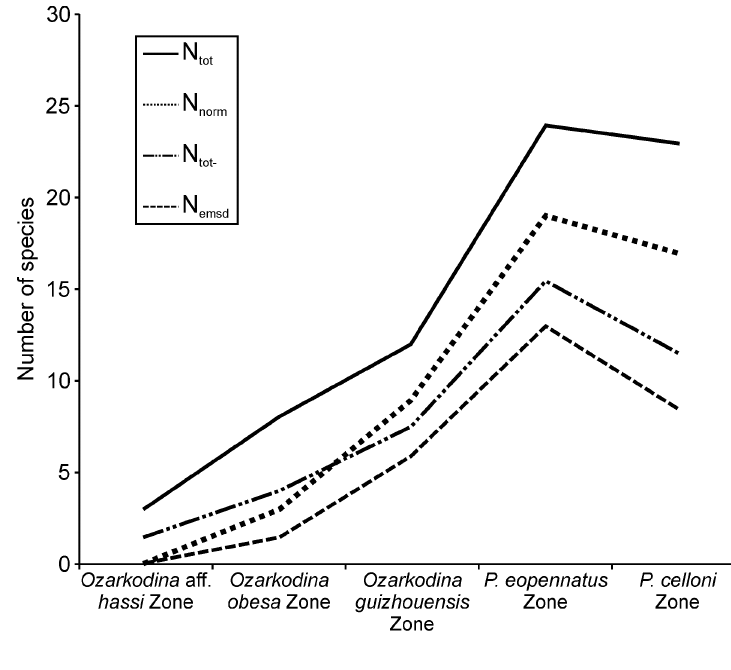
Fig. 3. Species richness curve of the Llandovery conodonts of the Upper Yangtze Platform. P ., Pterospathodus